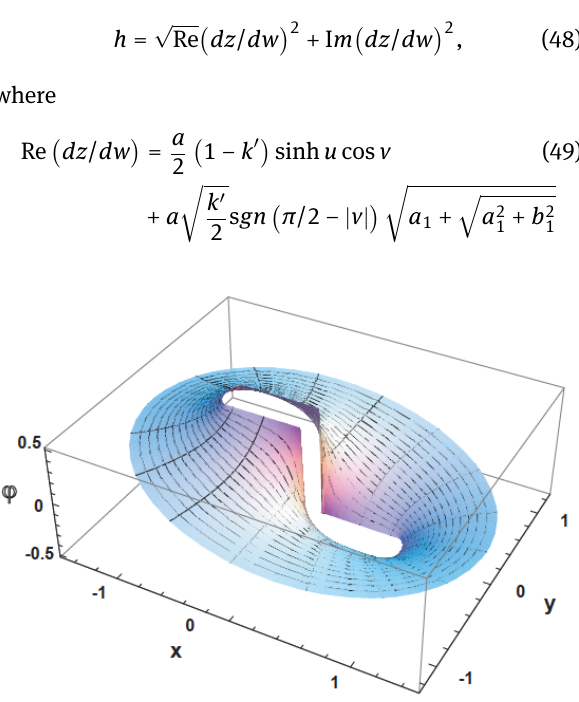
It should be mentioned that cylindrical elliptical coor- dinates were not employed in the solution presented in [1], nor were explicit forms of the stresses provided as in (41).